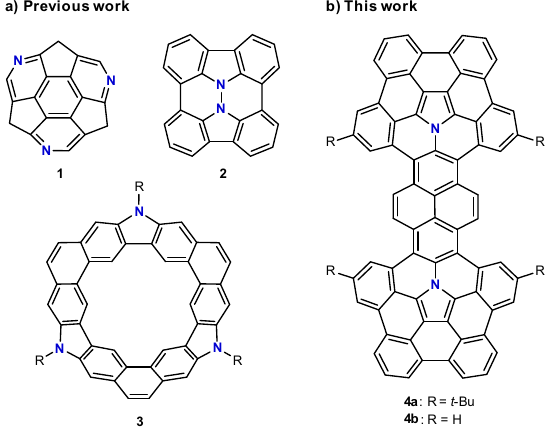
Fig. 1 Representative multiazafullerene fragment molecules. a Molecules reported in literature. b Molecules reported in this